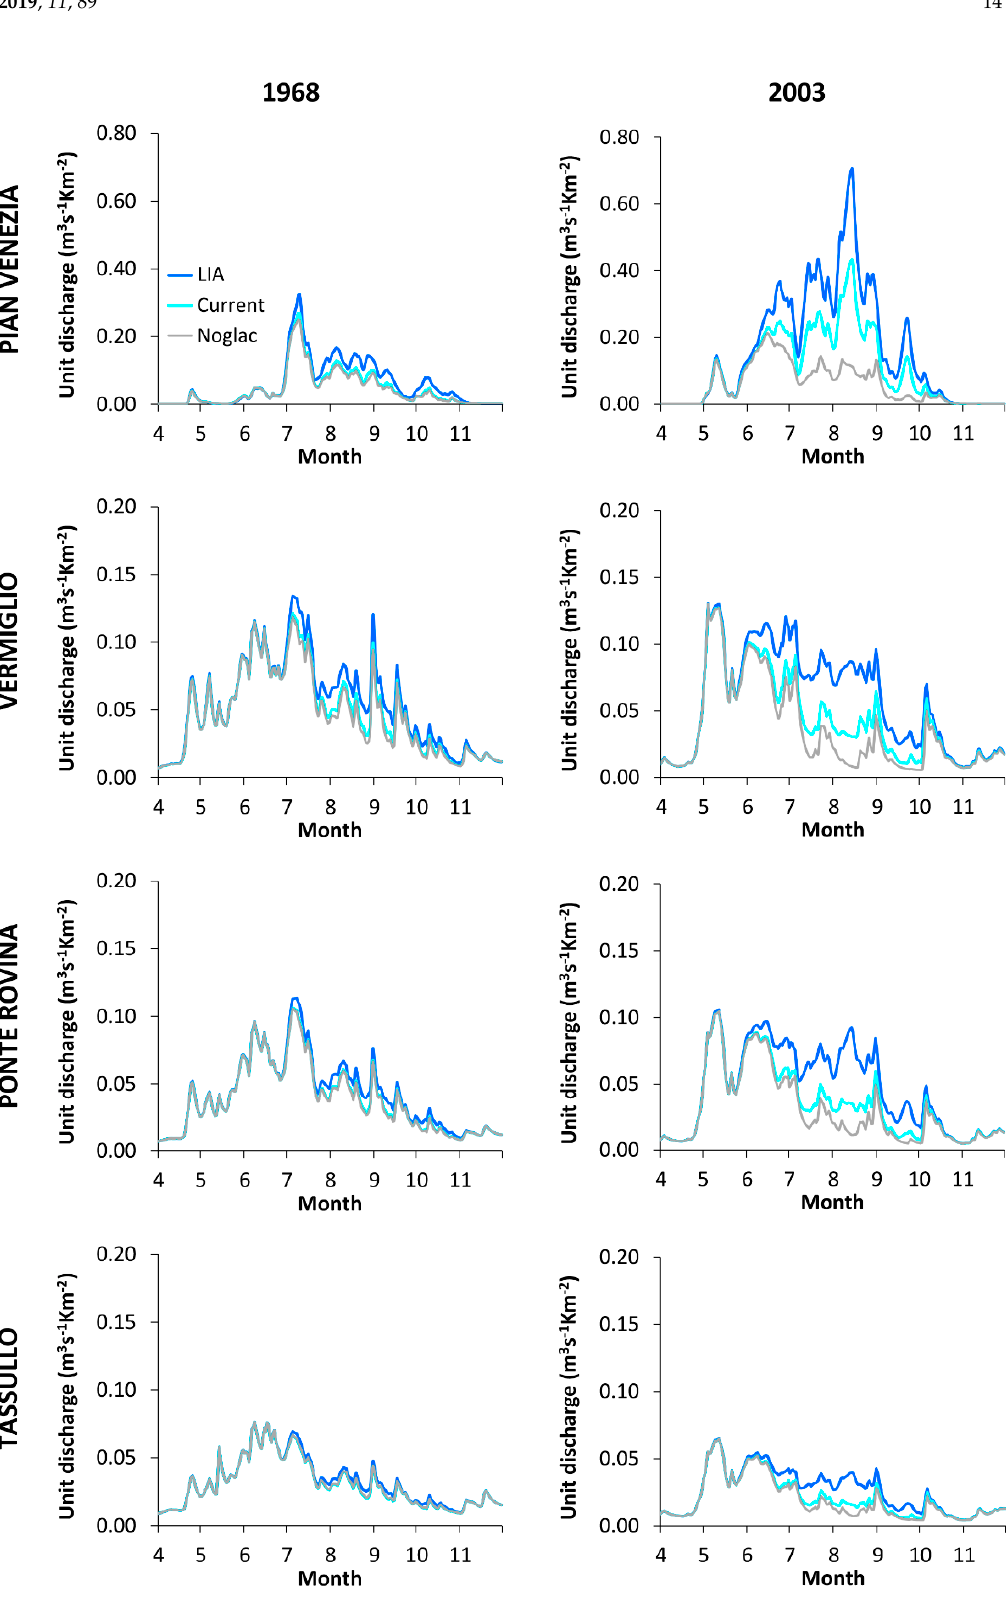
Figure 8. Daily unit discharge in 1968 (left column) and 2003 (right column) for different glacier extent (colors), in different catchments (rows). Please note that the vertical scale for Pian Venezia is different from the other three.